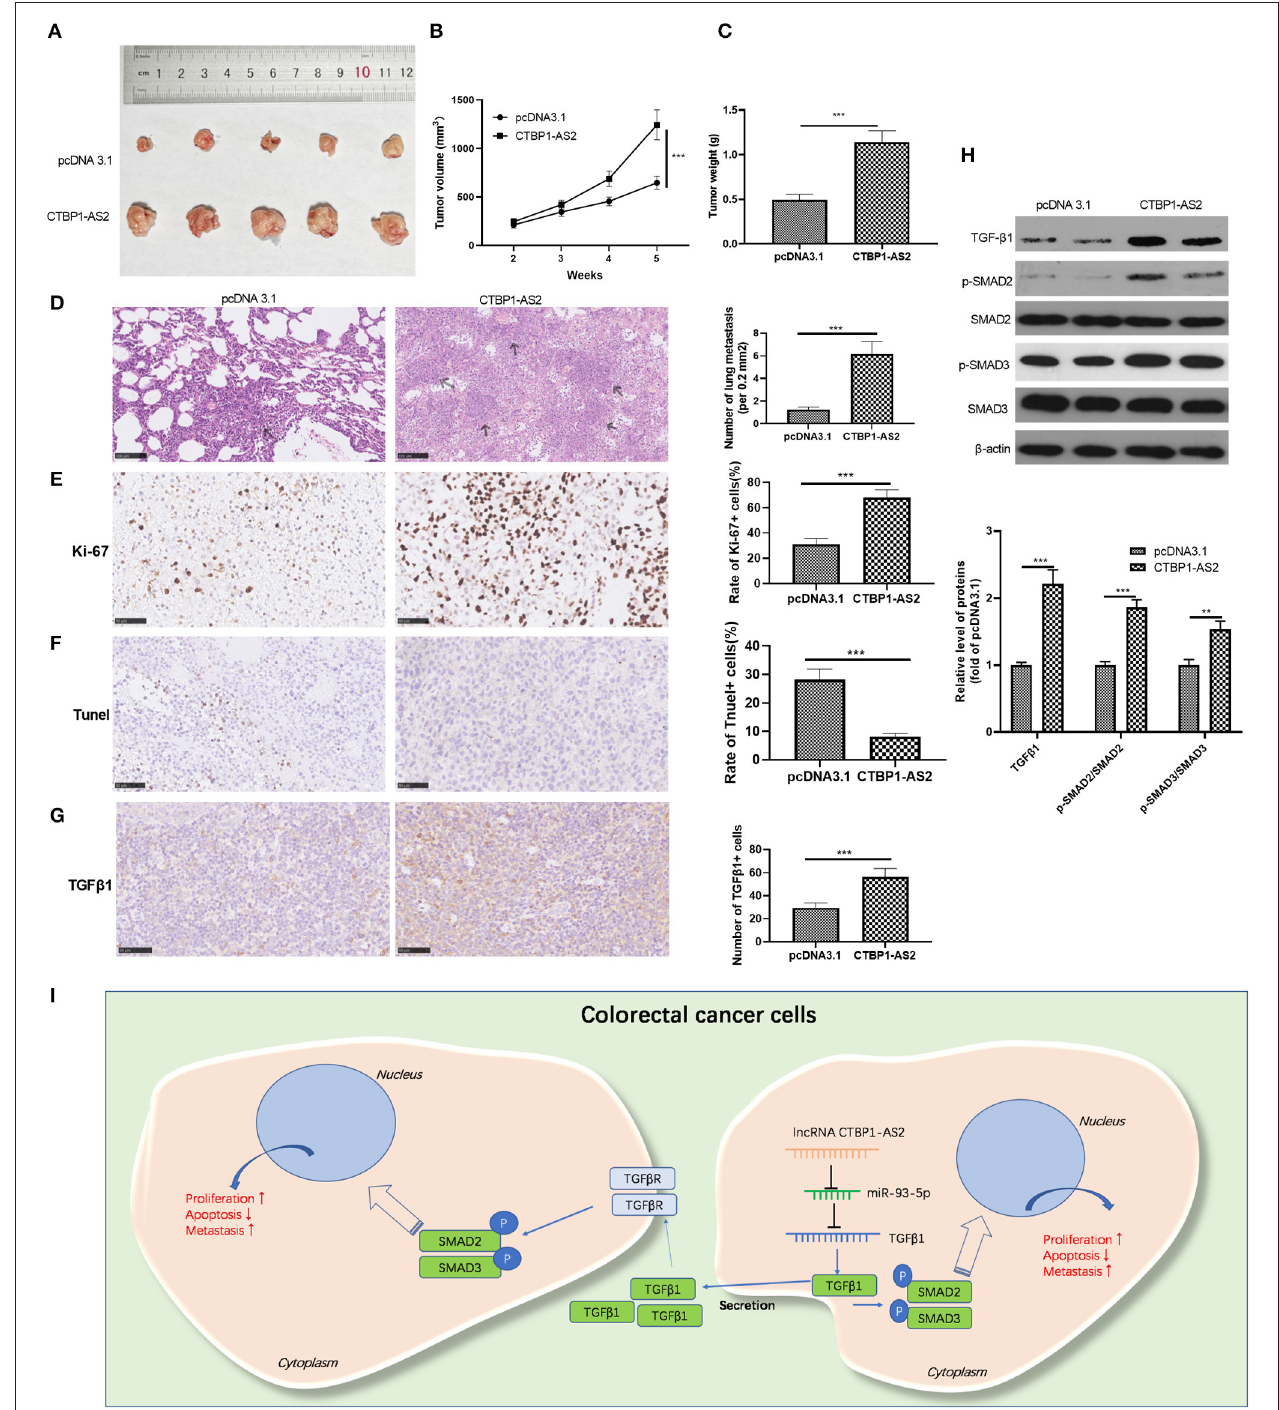
FIGURE 7 | Effect of CTBP1-AS2/miR-93-5p on CRC proliferation and invasion. (A,B) Construction of a cell model of miR-93-5p overexpression in SW620 cells, and adding CTBP1-AS2 overexpression plasmid to investigate the interaction of CTBP1-AS2-miR-93-5p axis in CRC. Use of RT-PCR to measure the levels of CTBP1-AS2 (A) and miR-93-5p (B) . (C) Detection of the levels of TGF- β 1, SMAD2, and SMAD3 in the cells by using Western blotting. (D) Use of CCK-8 to examine the cell proliferation. ** p < 0.01, *** p < 0.001 vs. miR-NC group, ##p < 0.01 vs. miR-93-5p group. (E) Use of the Transwell method to detect cell invasion. * p > 0.05, ** p < 0.01, *** p < 0.001. N = 3. CCK-8, cell counting kit-8; CRC, colorectal cancer; NC, negative control; NS, not significant; RT, reverse transcription; TGF- β , transforming growth factor- β